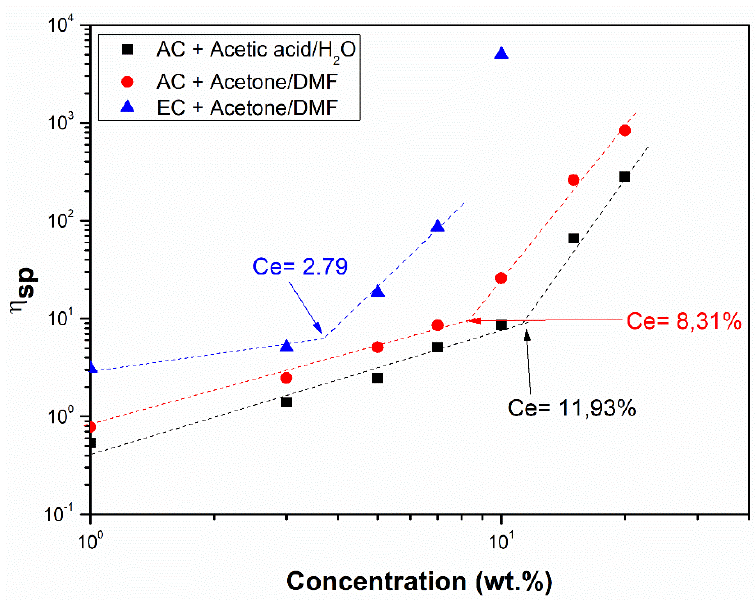
Figure 1. Concentration dependence of the specific viscosity for different solutions of AC and EC with different solvents.